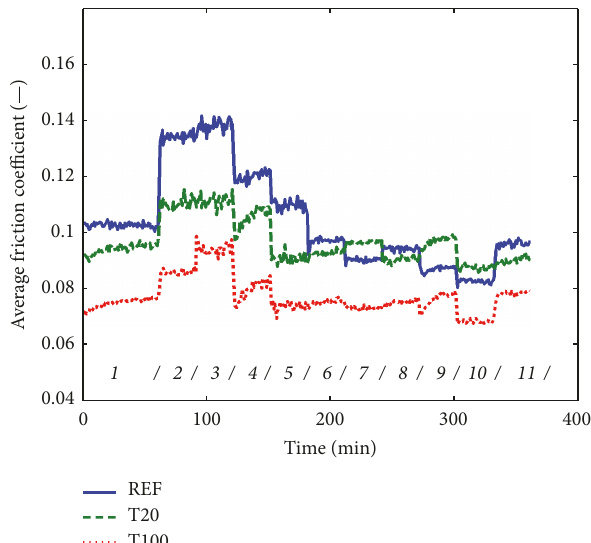
Figure 8: Measured friction coefficient, average of experiments for each surface type. The numbers above the 𝑥 -axis (italics) indicate the duration of each experimental cycle step.